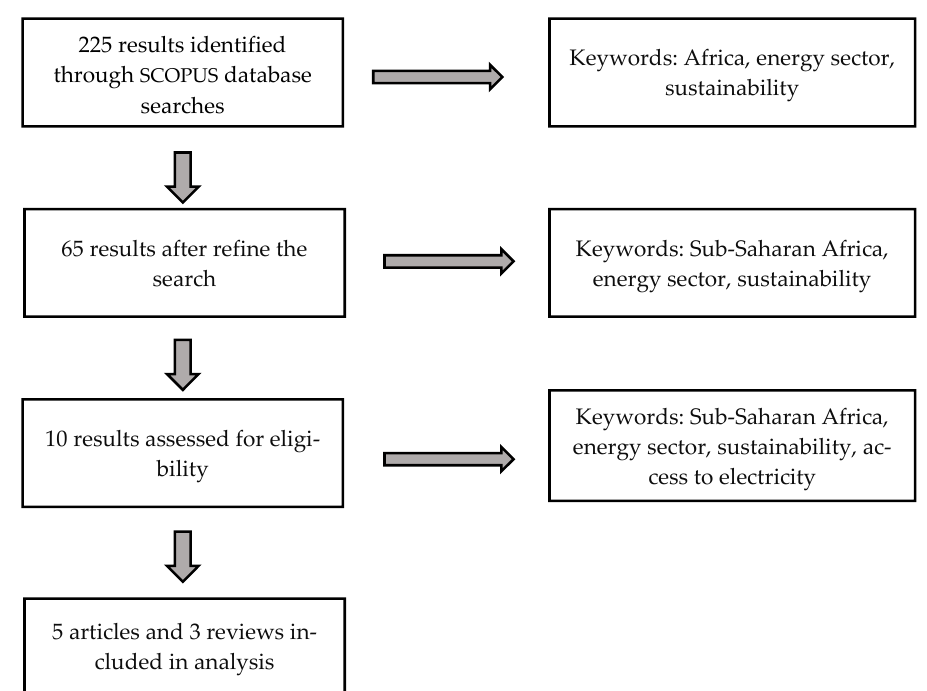
Figure 1. Flow diagramme. Source: own study.